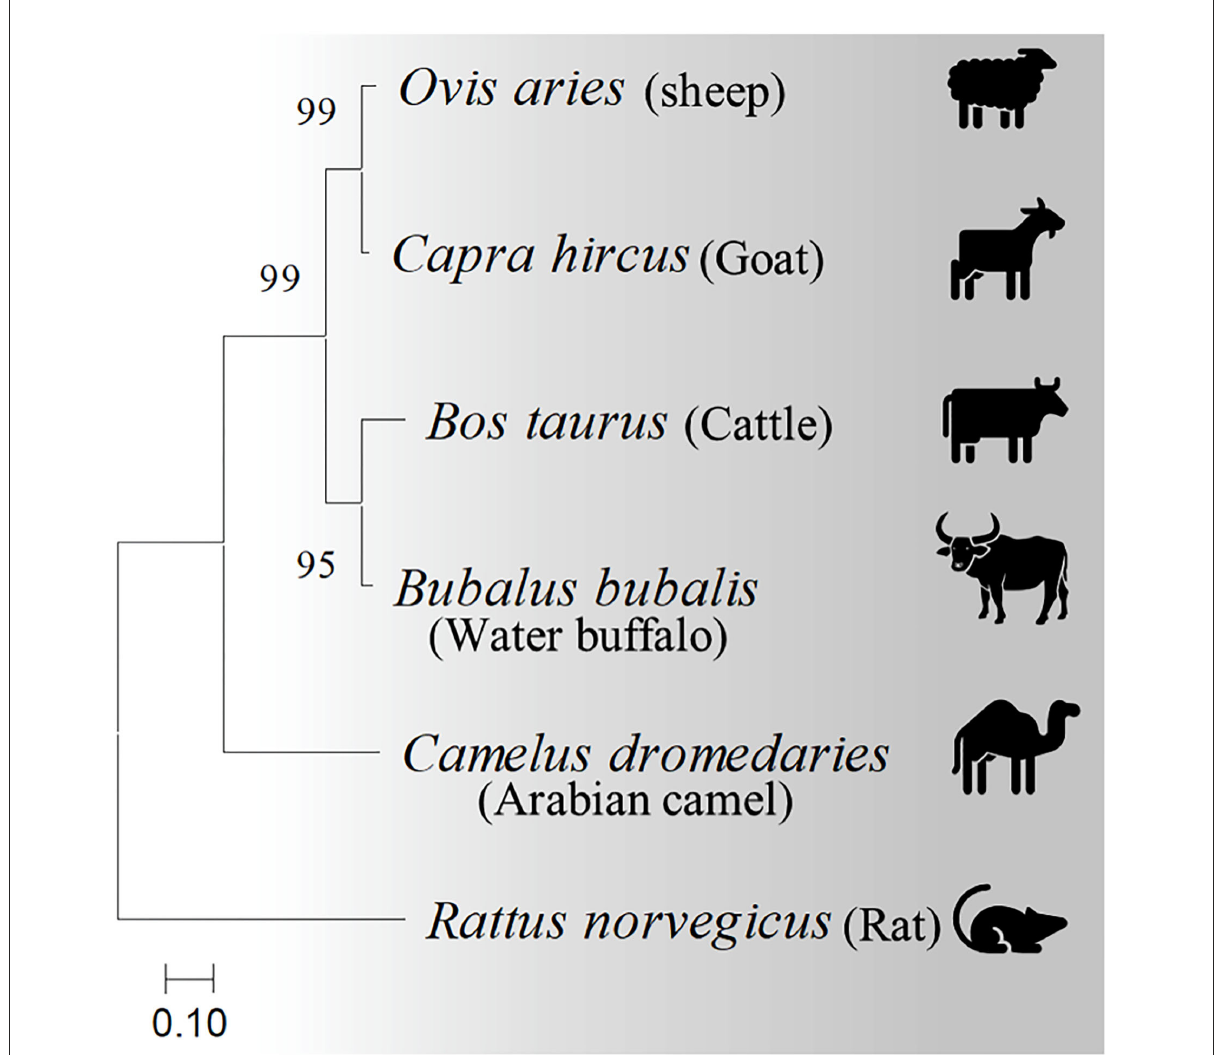
FIGURE2 Phylogenetic relationships among casein homologs from different domestic animals. A neighbor-joining tree inferred from combined alpha-S1-, alpha-S2-, beta-, and kappa-casein amino acid sequences shows the phylogenetic positions of five other animals. The phylogenetic tree is derived from the alignment of four concatenated casein from sheep, goats, cattle, Arabian camels, and water buffalos. The tree was rooted in Rattus norvegicus . Bootstrap support values are indicated on the nodes. Bootstrap values were calculated from 1,000 replications.